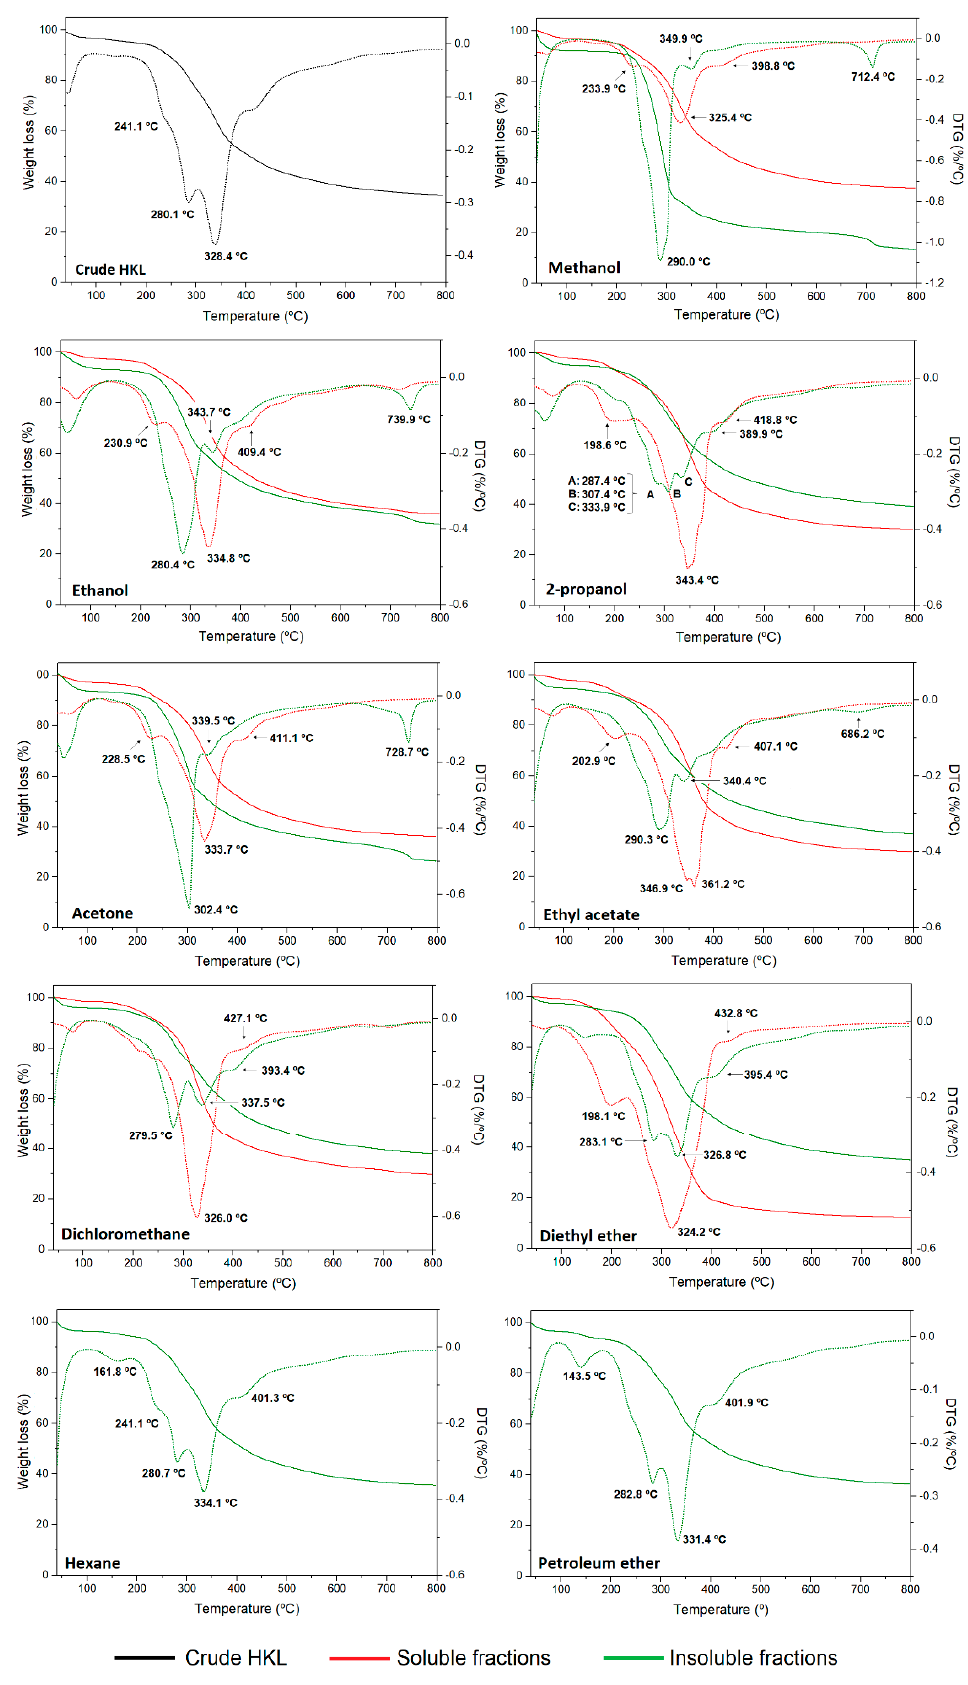
Figure 5. TG and DGT curves of crude HKL, soluble and insoluble fractions.